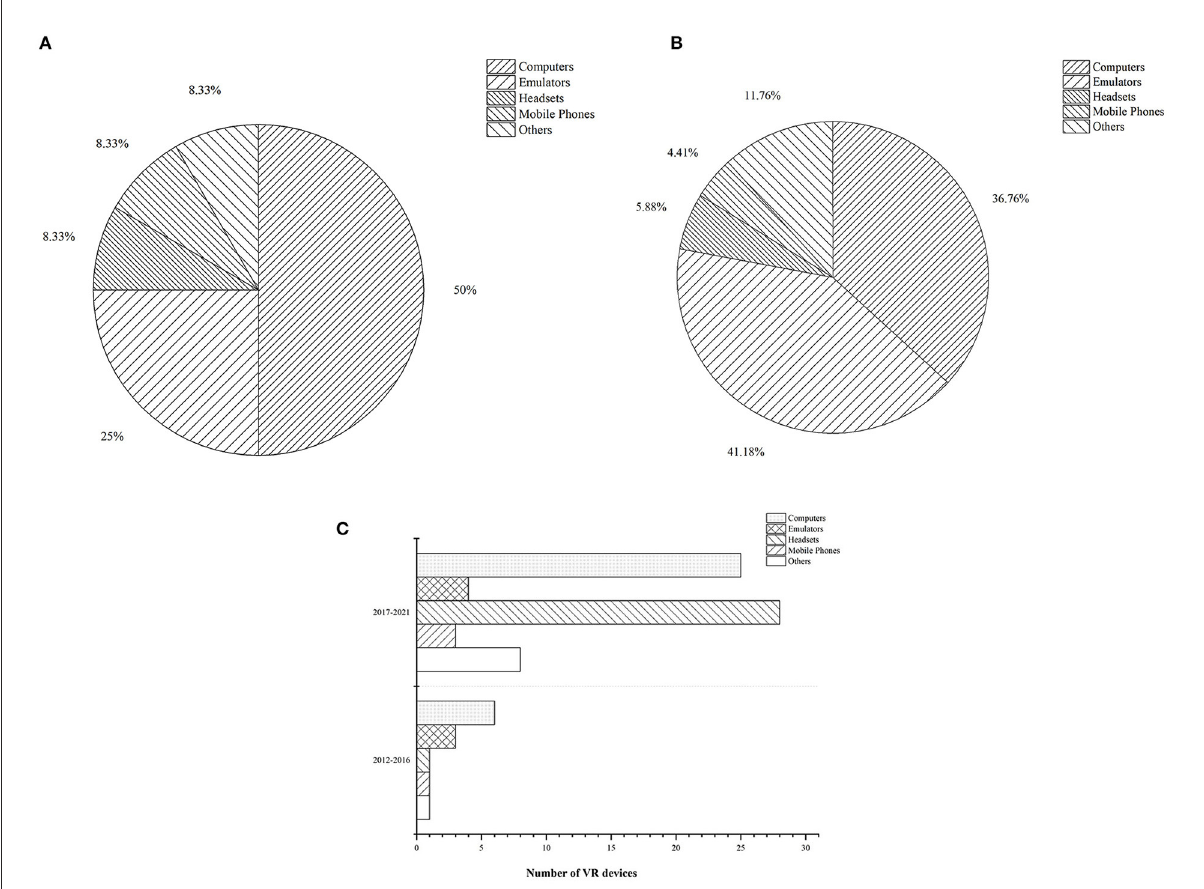
FIGURE4 Statistics of VR teaching equipment. (A) VR Equipment (2012-2016). (B) VR Equipment (2017-2021). (C) Number of VR